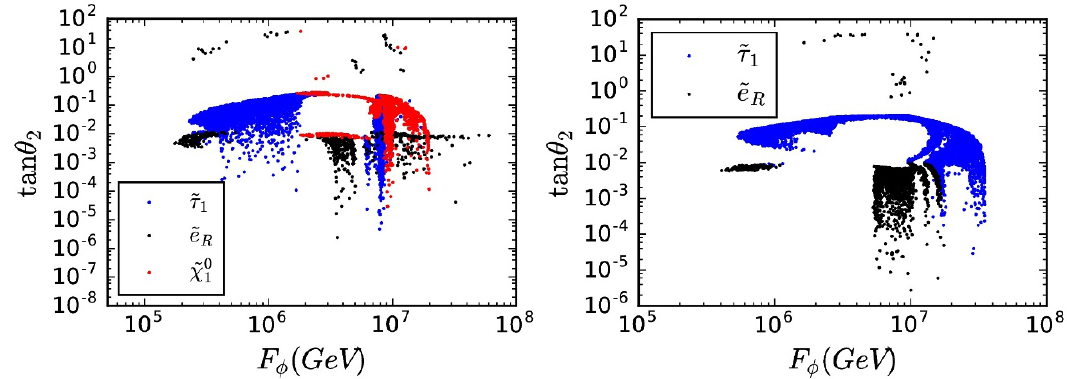
Figure 4 . Allowed regions of tan (cid:18) 2 vs F (cid:30) with a = 3(left panel) and a = 2(right panel) in scenario II. All points satisfy the constraints from (I) to